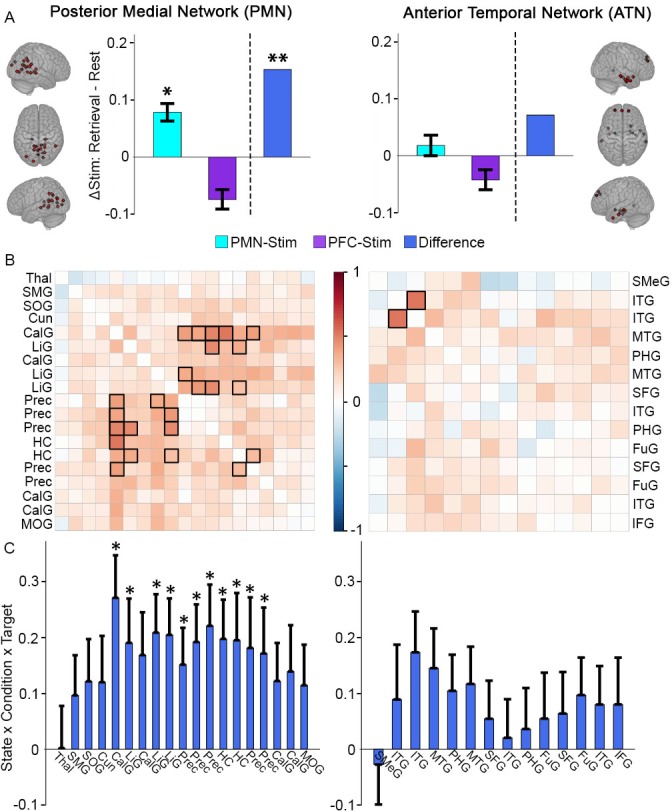
Greater memory task-dependent connectivity increases due to PMN-targeted versus PFC-targeted control stimulation for the PMN.(A) Stimulation effect on mean connectivity (all regions to all other regions) during memory retrieval relative to rest for the PMN (left) and the ATN (right). Error bars indicate subject-level standard error of the mean. *=p < 0.05, **=p < 0.01 for the interaction between stimulation condition and state in each group, or the three-way interaction between condition, state, and stimulation location. (B) The same effect of stimulation on connectivity between each pair of regions in the PMN (left) or ATN (right). Coloration represents the beta-weight of the three-way interaction effect, with significant cells shown in bold (FDR corrected p<0.05). (C) The same effect of stimulation on connectivity for each region in the PMN to all other PMN regions (left) and each region in the ATN to all other ATN regions (right). Error bars indicate standard error of the mean of the three-way interaction. *=FDR corrected p<0.05. Regions are shown in Figure 2—figure supplement 1 and region abbreviations are expanded in Supplementary file 2.10.7554/eLife.49458.005Figure 2—source data 1.PMN/ATN network-based analysis.Subject: 1–16 = PMN targeted group, 17–32 = PFC targeted group. State: Autobiographical memory task (Retrieval) or resting-state (Rest). Condition: Full stimulation (Stim) or sham stimulation (Sham). Target: PMN-targeted (Par) or PFC-targeted (Ant). Order: Full stimulation first (1) or sham stimulation first (2). Connectivity: Average activity correlation between network regions for that scan. tSNR: Average whole-brain temporal signal to noise ratio for that scan. Network: Posterior-medial (PM) or anterior-temporal (AT).